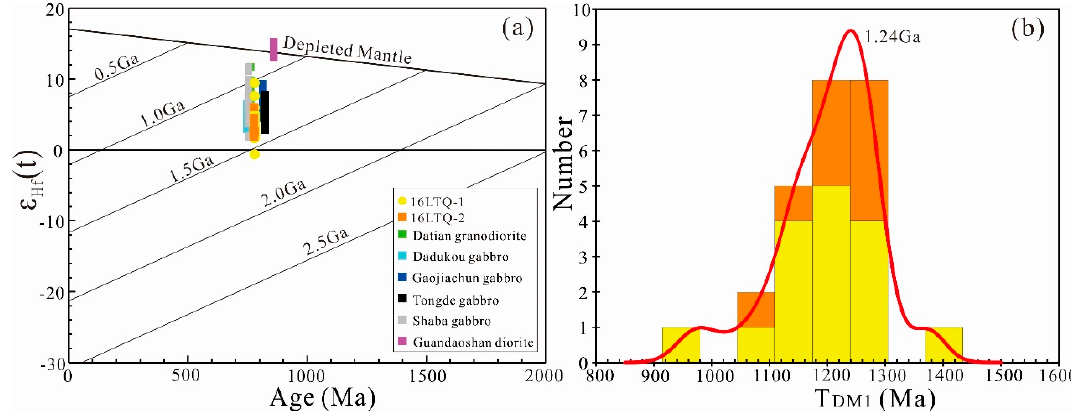
Figure 9. ( a ) Zircon Hf-isotope compositions diagram of LTQ (16LTQ-1, 16LTQ-2) and other Neoproterozoic intrusions in the western margin of YZB. Data of other intrusions are from [3,8,31,33–35,86]; ( b ) Histogram of model Hf ages (T DM1 ) for the LTQ in the western YZB.